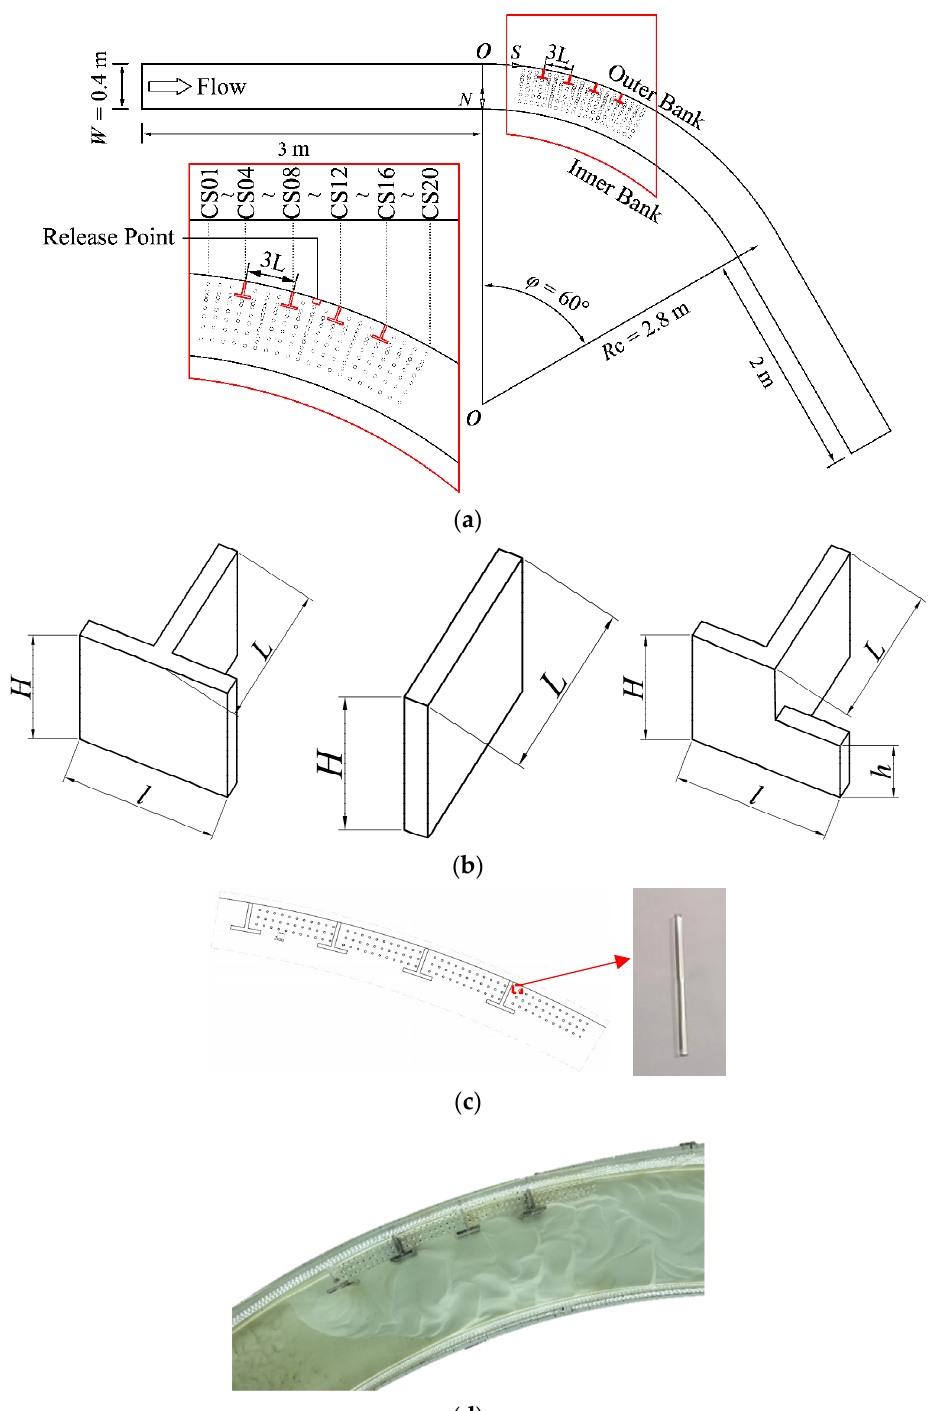
Figure 1. Experimental arrangements: ( a ) planar shaped parameters related to the experimental flume and measuring point arrangement (T-shaped groin as an example. The black circle represents the velocity measurement point; the inorganic salt solution release point is represented by the red box in the middle bank of the second and third groins. ‘CS’ is the abbreviation of ‘Cross Section’); ( b ) Types of groins (From left to right is I-shaped groin (I), T-shaped groin (T), Upstream Wing Submerged T-shaped Groin (ST)); ( c ) Vegetation arrangement in groin field; ( d ) Experimental